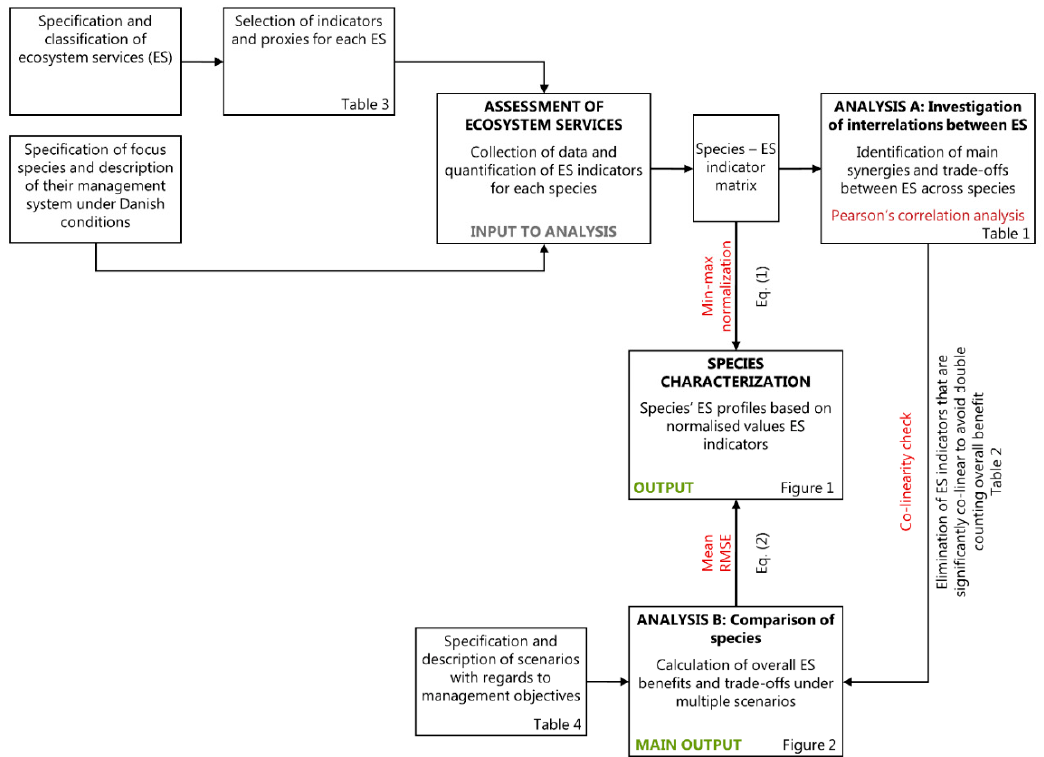
Figure 1. Methodological framework and analytical approach of the study.